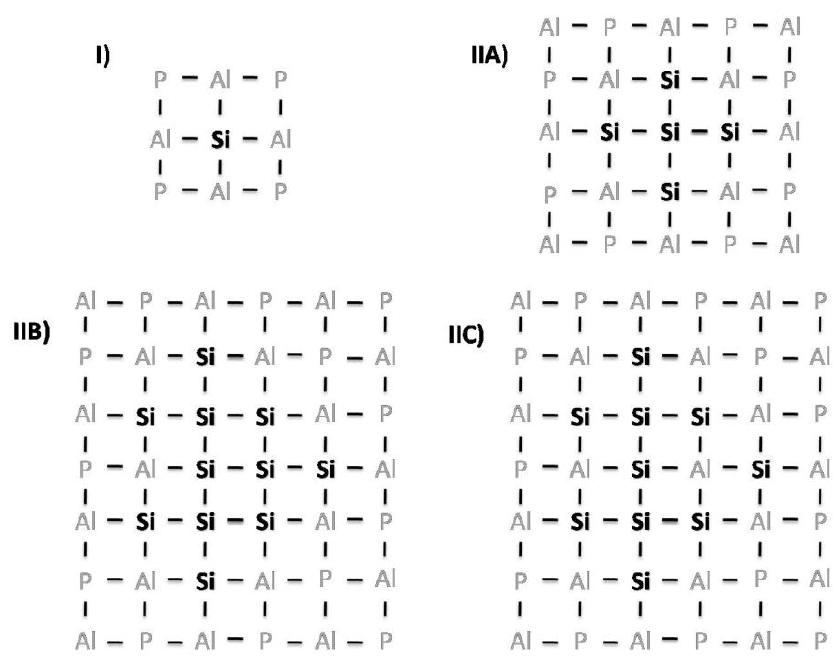
Figure 3. Distribution of Si in SAPOs: ( I ) isolated Si; ( II ) “silica islands” with 5 (IIA), 11 (IIB) and 10 (IIC) Si atoms (reprinted minimally modified from ref. 26 copyright © 1994 with permission from Elsevier [26]).